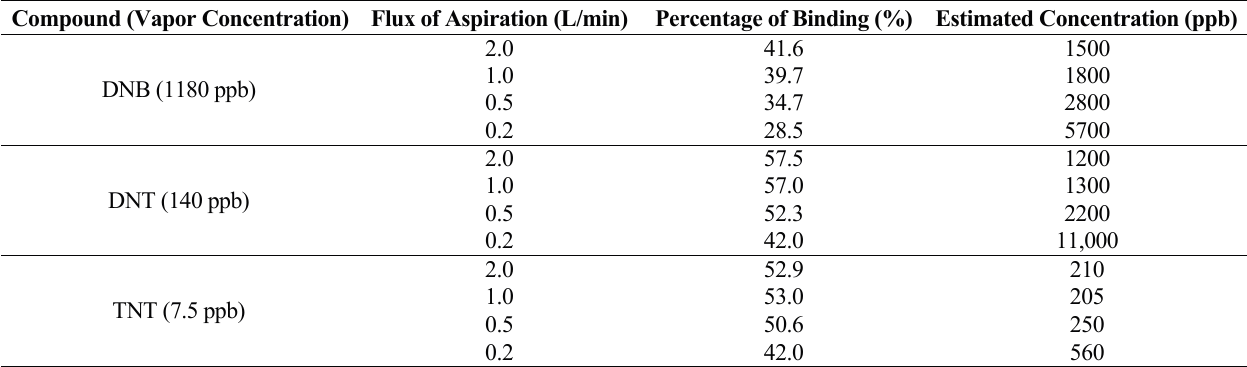
Table 3. Percentages of antibody bound by indirect competitive assay and calculated concentrations of sample solution collected using preconcentrator [63].